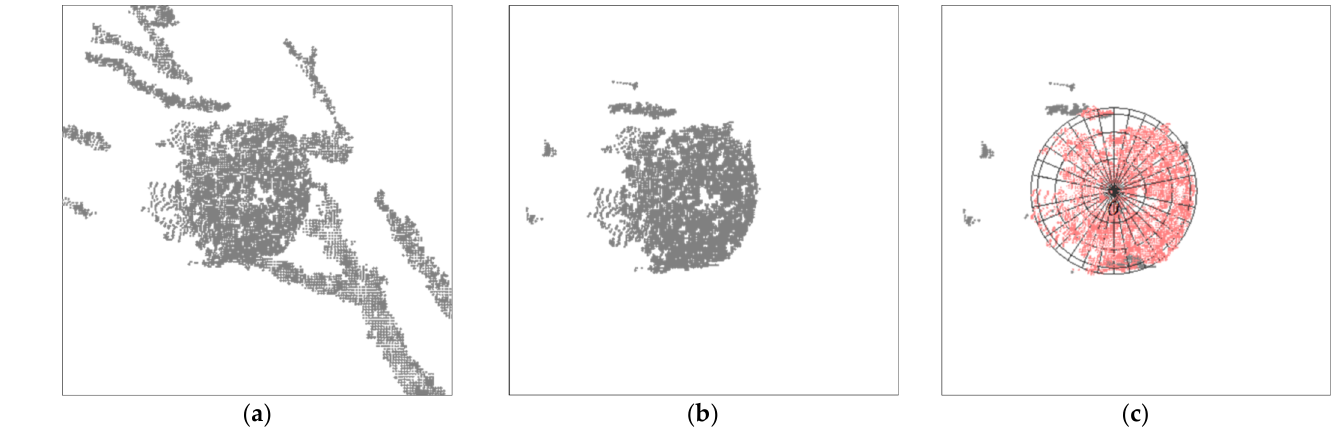
Figure 7. Fitting a sphere to the apple: ( a ) global point cloud of the detected apple and tree within the camera image; ( b ) point cloud in the bounding box; ( c ) spherical fitting results. The pink point cloud in ( c ) is the RANSAC apple surface point cloud; the sphere is fitted by the least squares method.